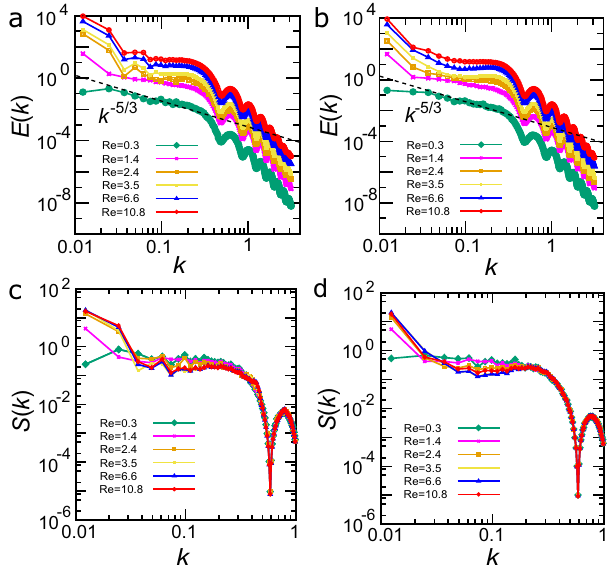
Fig. 6 Re-dependence on the fi nal energy spectrum E ( k ) and structure factor S ( k ). a , b The k -dependence of the kinetic energy E ( k ) for off-symmetric ( a ) and symmetric ( b ) cases as a function of Re. For low Re, where phase separation is not induced, we can see approximately the − 5/3 scaling law (see the dashed line) below the wavenumber corresponding to the particle size, which is the characteristic size of our system ’ s energy input. The scaling law suggests the inverse cascade characteristic of two-dimensional (2D) turbulence (see below). We stress that this scaling is observed only before the formation of the condensate. When the system-spanning condensate is formed by phase separation, we can no longer see such a scaling due to the formation of large-scale coherent fl ow structures 87 : The low wavenumber upturn re fl ects the macroscopic fl ow organisation accompanied by phase separation. We can con fi rm it by looking at the corresponding low-wavenumber upturns of the structure factor S ( k ) for asymmetric ( c ) and symmetric ( d ) cases. c , d The k -dependence of the structure factor S ( k ) for asymmetric ( c ) and symmetric ( d ) cases as a function of Re. Here we distinguish the rotation direction, as in Fig. 4 (see Materials and